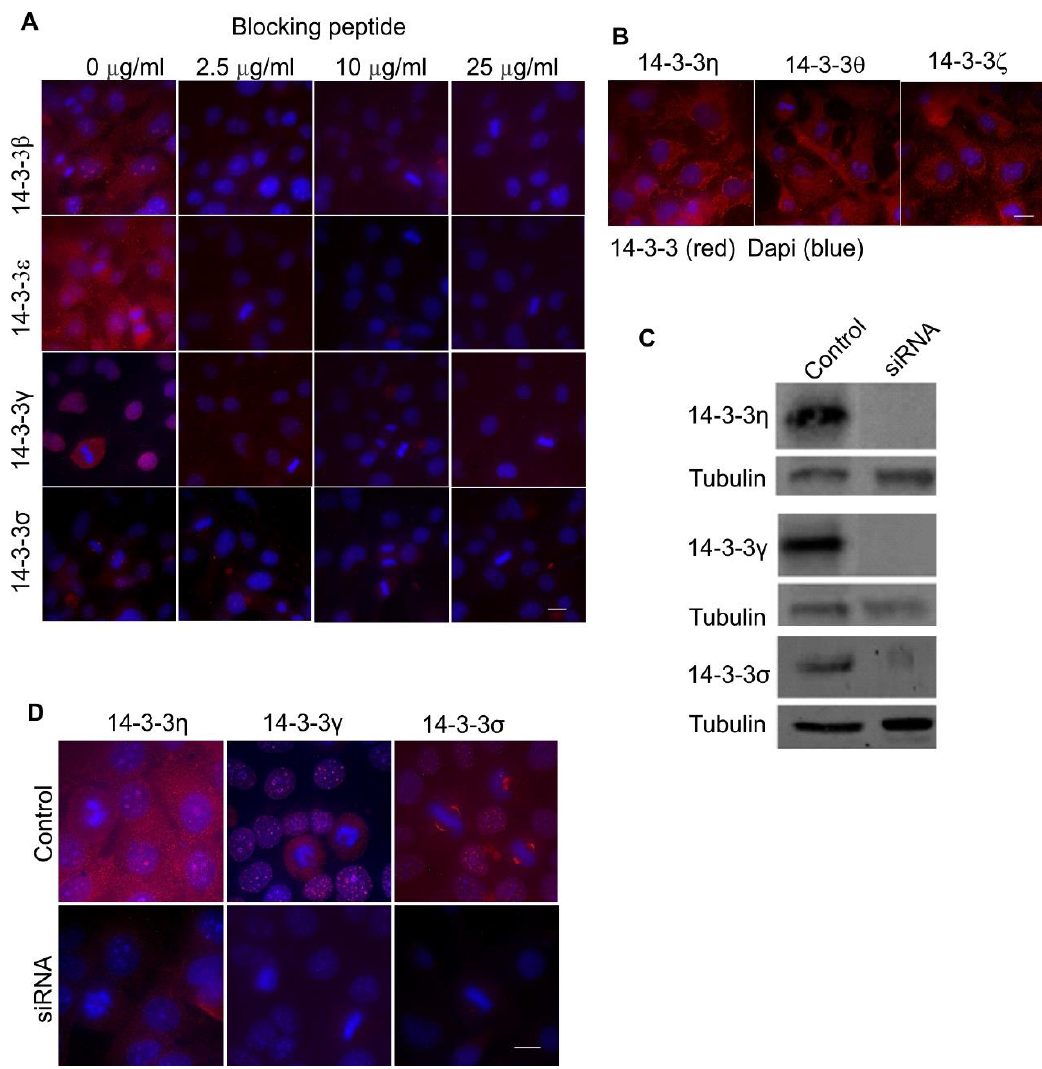
Figure 2. Control experiments to determine the specificities of the antibodies used in Figure 1 by indirect immunofluorescence in Cos-7 cells. ( A ) The effects of blocking peptides for 14-3-3β, ε, γ, and σ. The indirect immunofluorescence experiments were performed as described for Figure 1, except that the antibodies were incubated with blocking peptides of the indicated concentration for 1 h prior to incubation with the cells. ( B ) The subcellular localizations of 14-3-3η, θ , and ζ were determined by antibodies different from those used in Figure 1; ( C ) 14-3-3η, γ, and σ were knocked down in HEK 293 cells by siRNA, and the expressions of these isoforms were examined by immunoblotting with the corresponding antibodies. ( D ) 14-3-3η, γ, and σ were knocked down in HEK 293 cells by siRNA and the expressions of these isoforms were examined by indirect immunofluorescence with the corresponding antibodies. Scale bar = 10 µm.